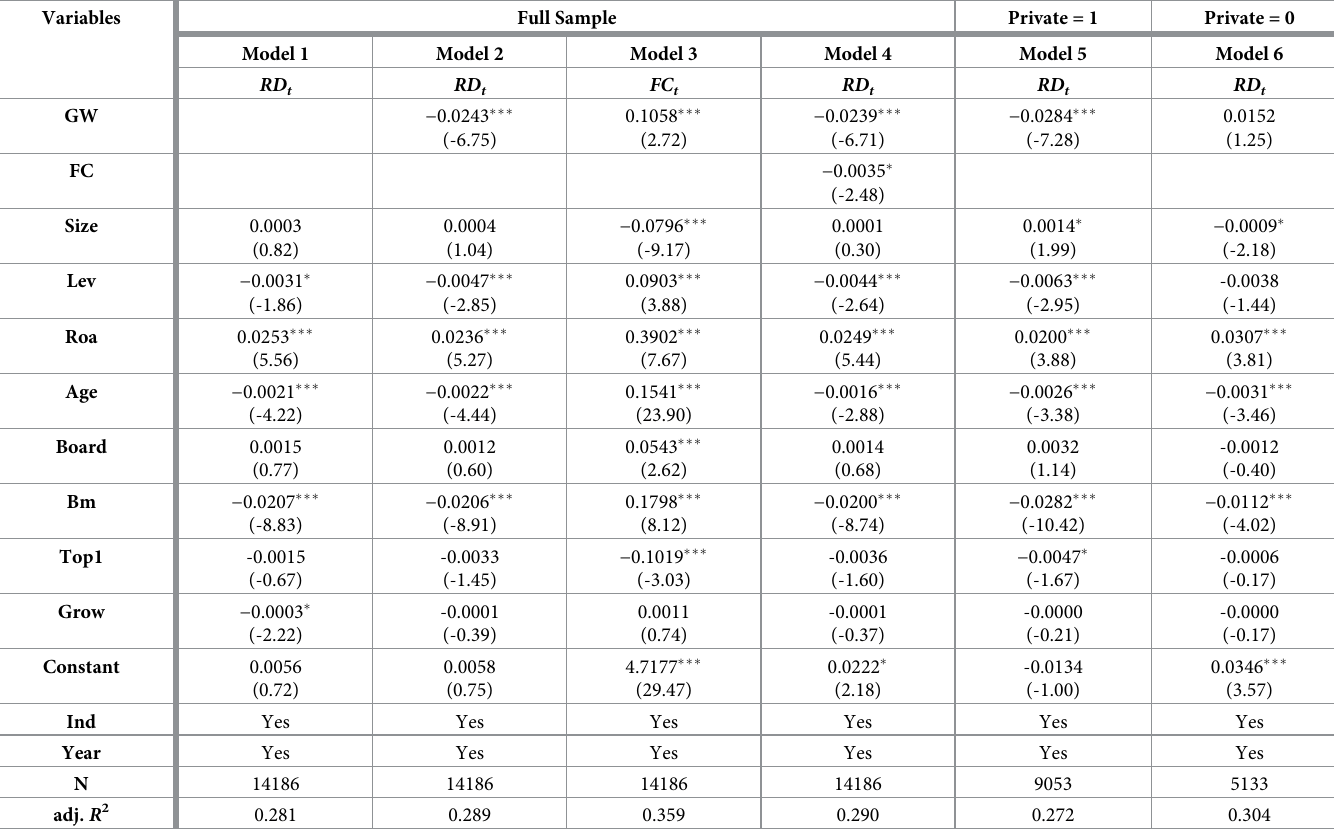
Table 3. Regression results of hypothesis H1, H2 and